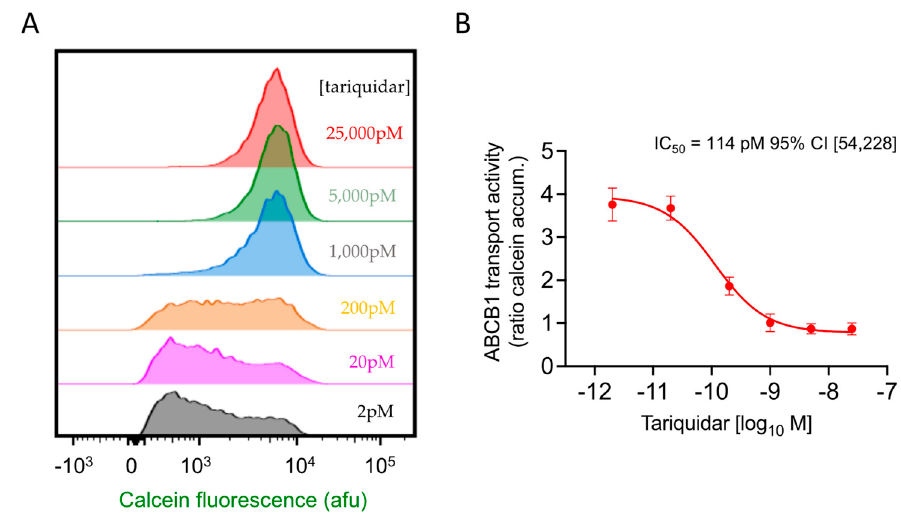
Figure 3. Potency of tariquidar for inhibition of ABCB1. ( A ) Exemplar histograms showing the increase in calcein accumulation in Flp-In-ABCB1 cells with increasing concentration of tariquidar. ( B ) Non-linear regression analysis of ABCB1 activity (calculated as a ratio using Equation (1)) versus tariquidar concentration. The mean activity +/ − standard error of the mean (SEM) is plotted ( n = 3 biological repeats). Tariquidar IC 50 = 114 pM with a 95% confidence interval (CI 54 to 228 pM). 2.5. Four of the Six Test Compounds Fully Inhibit ABCB1 for the Transport of Calcein-AM